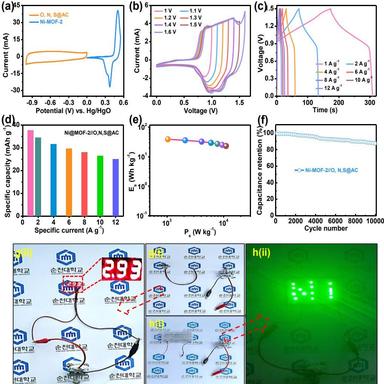
(a) CVs of the positive electrode (Ni-MOF-2) and the negative electrode (O, N, S@AC) half-cell at 5 mV/s scan rate, (b) CVs of HSC for different operating voltage at a scan rate of 5 mV/s, (c) GCD curves of HSC at various specific currents (d) Cs at specific currents 1, 2, 4, 6, 8, 10, and 12 A/g, (e) Ragone plot of the HSC, (f) Cyclic stability of HSC device at a current density of 5 A/g, (g (i)) Three-digit LED voltmeter without load, (g (ii)) Three-digit LED voltmeter powered by serially connected two HS